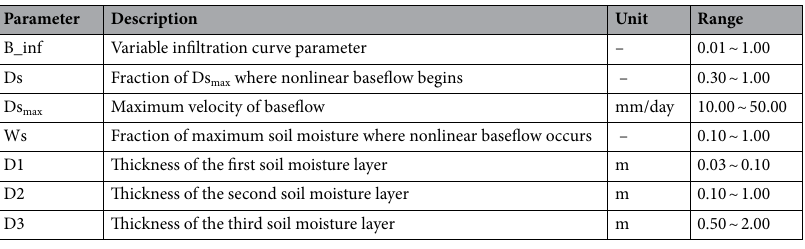
Table 1. Description of the calibrated parameters of the VIC model in